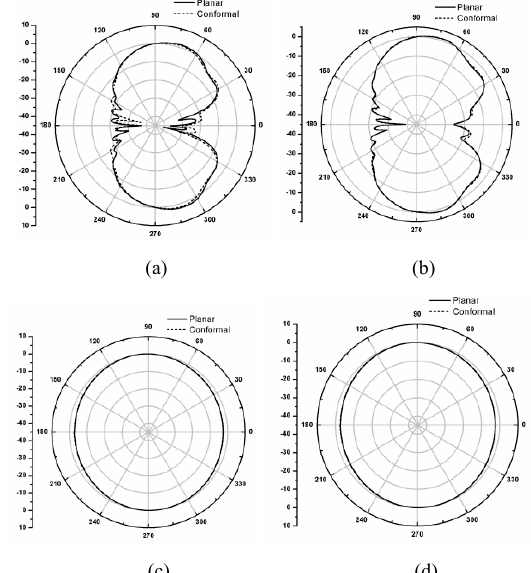
Figure 8: The measured radiation patterns of planar and conformal antenna (a) E-plane pattern at 1.5GHz (b) E-plane pattern at 1.57GHz (c) H-plane pattern at 1.5GHz (d) H- plane pattern at